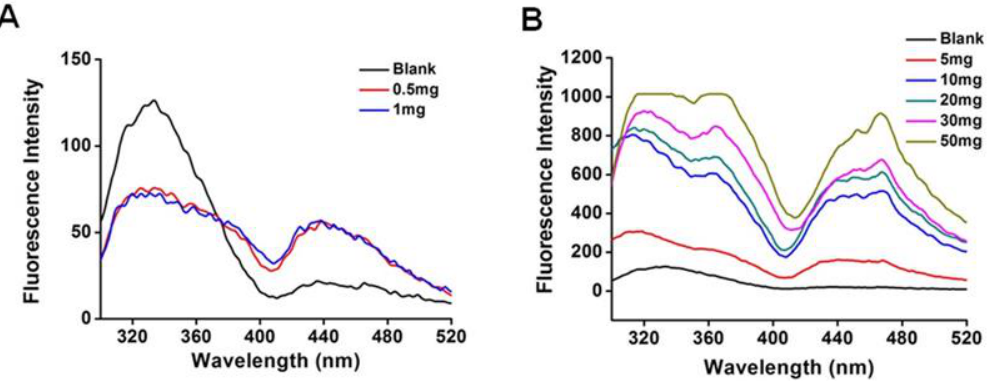
Figure 1. The fluorescence emission spectrum of amorphous nanosuspensions (ANSs) with paclitaxel (PTX) from 0–1 mg ( A ) and from 5–50 mg ( B ). (PTX) from 0–1 mg ( A ) and from 5–50 mg ( B